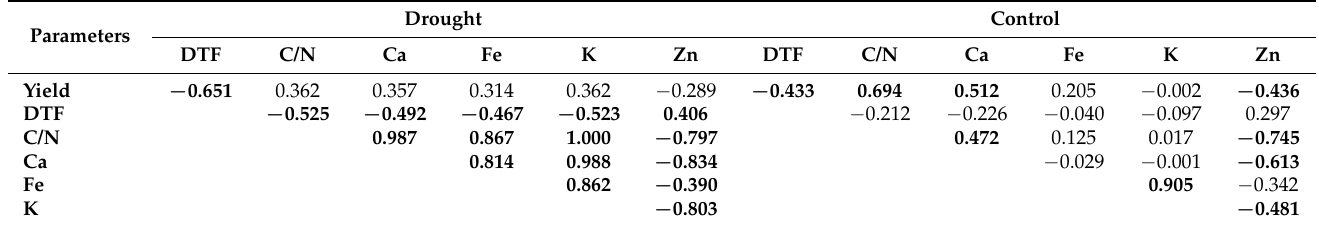
Table 5. Correlation analysis between days to flowering and yield, C and N concentration balance, and leaf nutrient accumulations (Ca, Fe, K, and Zn) in the different grain legumes under the different treatments (normal irrigation control vs. drought).